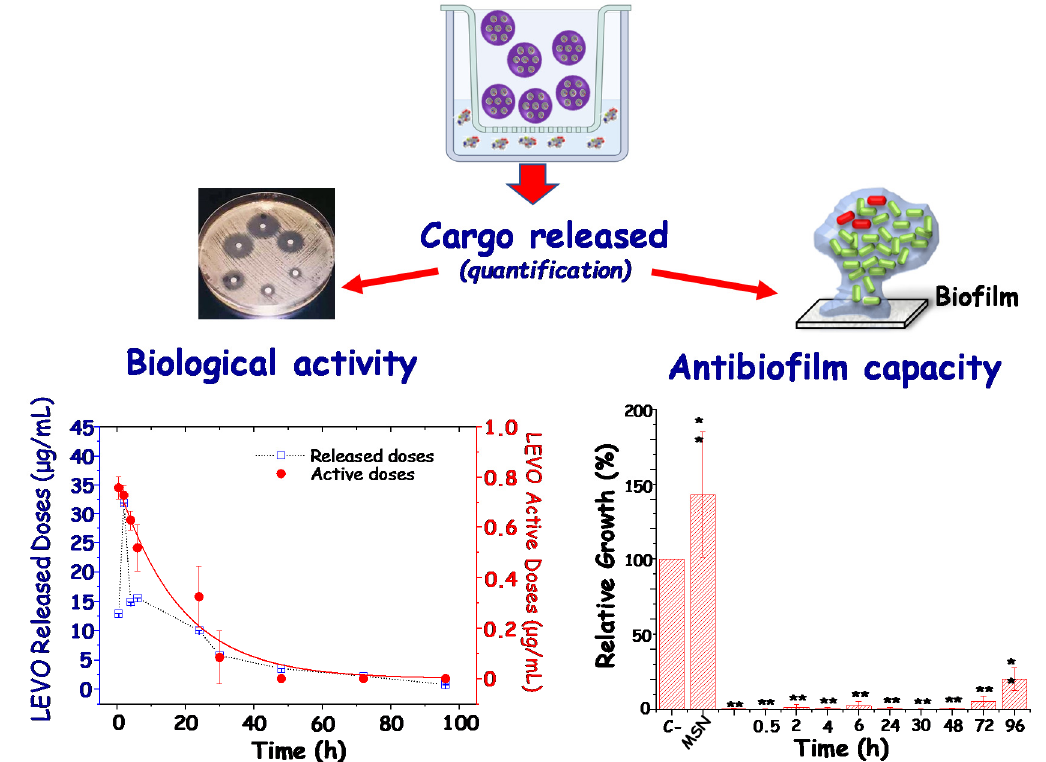
Figure 6. Top: Schematic depiction of the experimental design to carry out in vial drug delivery assays using antibiotic- loaded pure-silica MSNs, and subsequent quantification of cargo released doses, biological activity and antibiofilm capacity evaluations. Left graph: levofloxacin (LEVO) active doses against S. aureus bacteria (red curve) and LEVO released doses (blue curve) at different tested times. Right graph: In vitro antibiofilm activity of LEVO released doses in mature S. aureus biofilms. Adapted with permission from Aguilar et al. [53], Micropor. Mesopor. Mat., published by Elsevier, 2021.